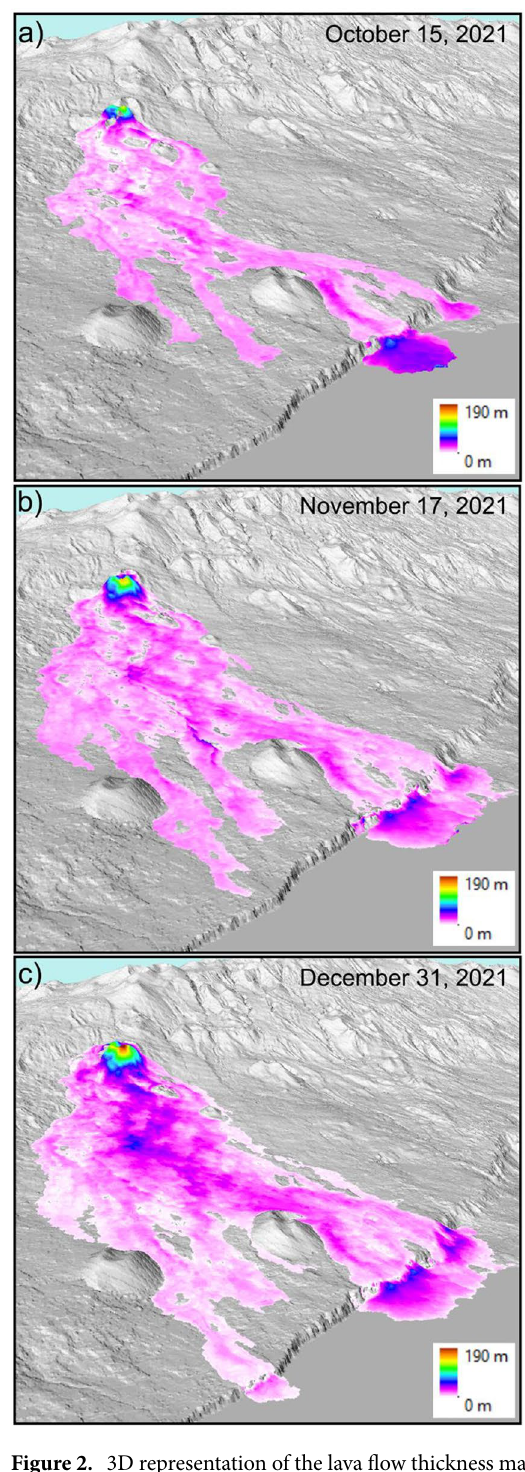
Figure 2. 3D representation of the lava flow thickness maps derived from ( a ) TanDEM-X (October 15, 2021), ( b ) TanDEM-X (November 17, 2021) and ( c ) Pléiades (December 31, 2021) acquisitions in comparison with the pre-eruption LiDAR DSM (hillshade in background). North is to the left, image width is 3.6 km. Maps created using ESRI ArcScene